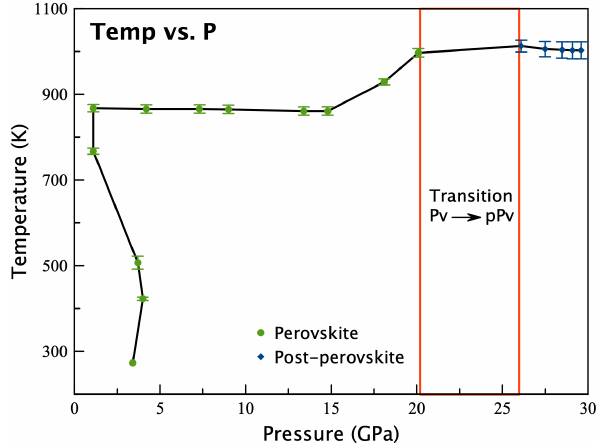
Figure 1. Pressure–temperature path during the experiment. Start of high-temperature compression is at 1.1GPa and 868K. Perovskite to post-perovskite transformation is observed between 20.1 and 26.1GPa.